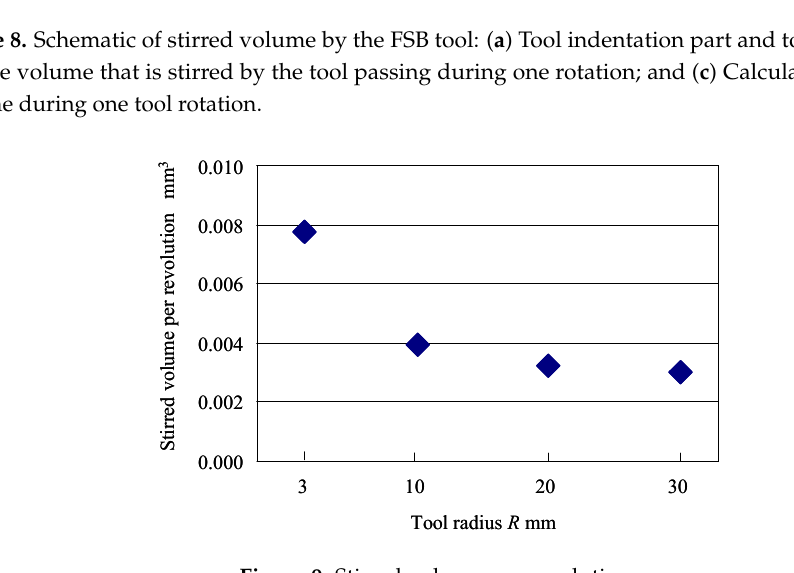
Figure 9. Stirred volume per revolution.